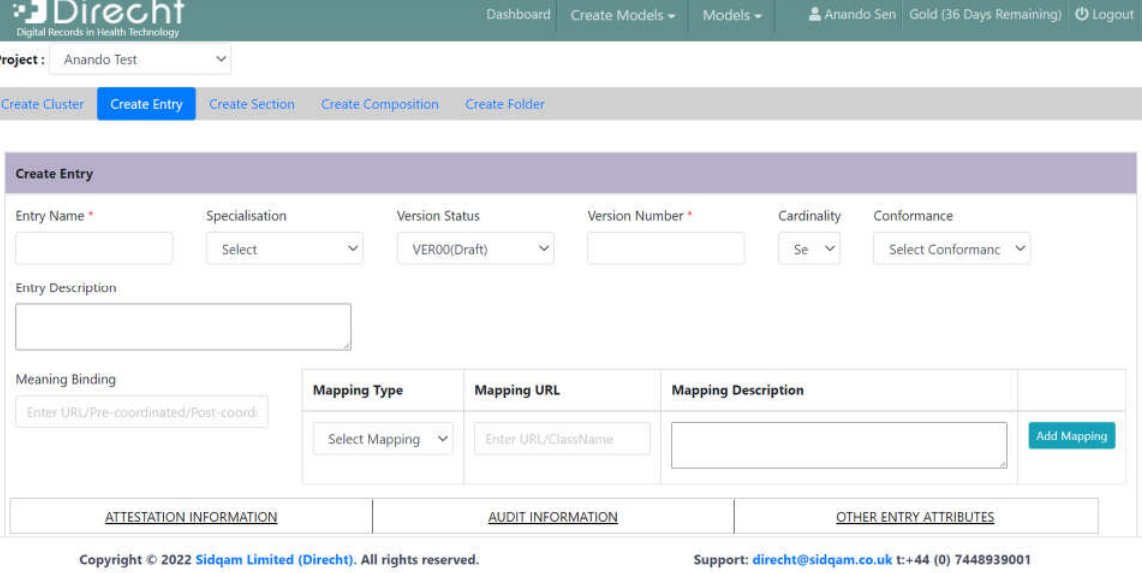
Figure 3. Image showing the ‘Create Entry’ screen in Direcht.